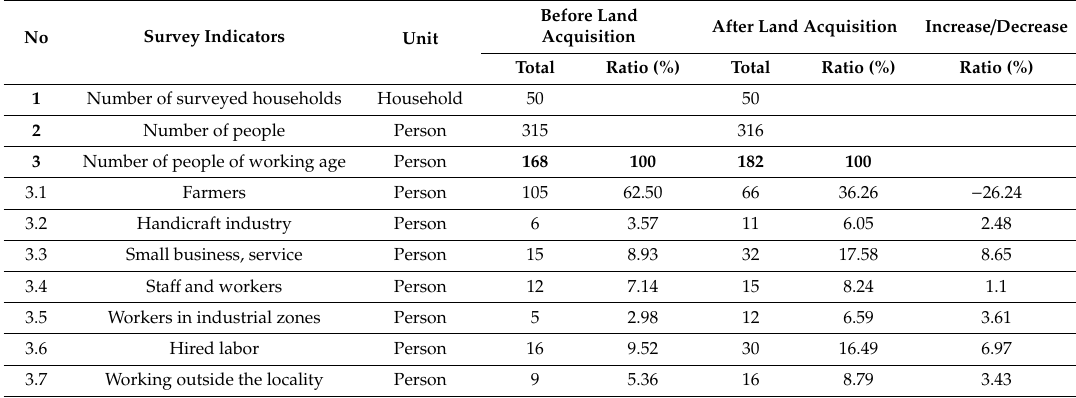
Table 2. The change in labor structure before and after land acquisition.